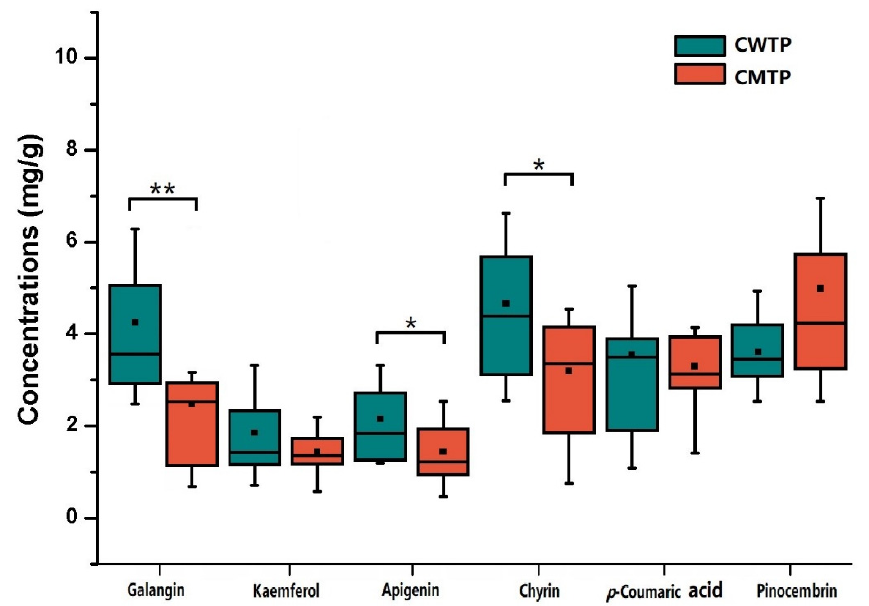
Figure 6. Box-plot graphic for the concentrations of the discriminating compositions in CWTP and CMTP for illustrative purposes. * p < 0.1, ** p < 0.05, Wilcoxon test with FDR